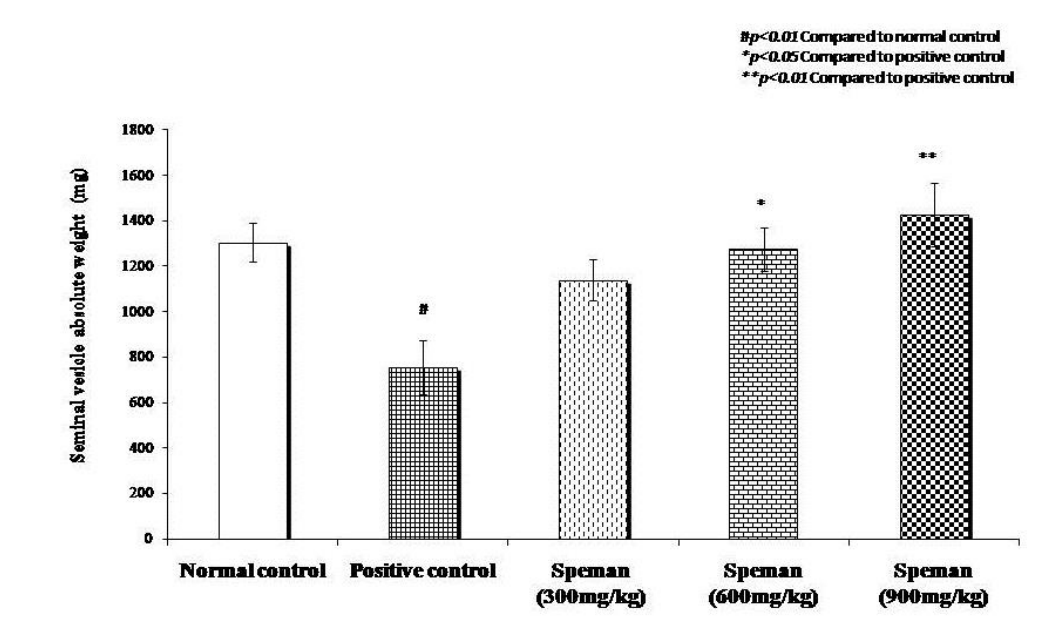
Figure 2: Effect of Speman ® on the absolute weight of seminal vesicle in an experimental model of CP-induced oligospermia in